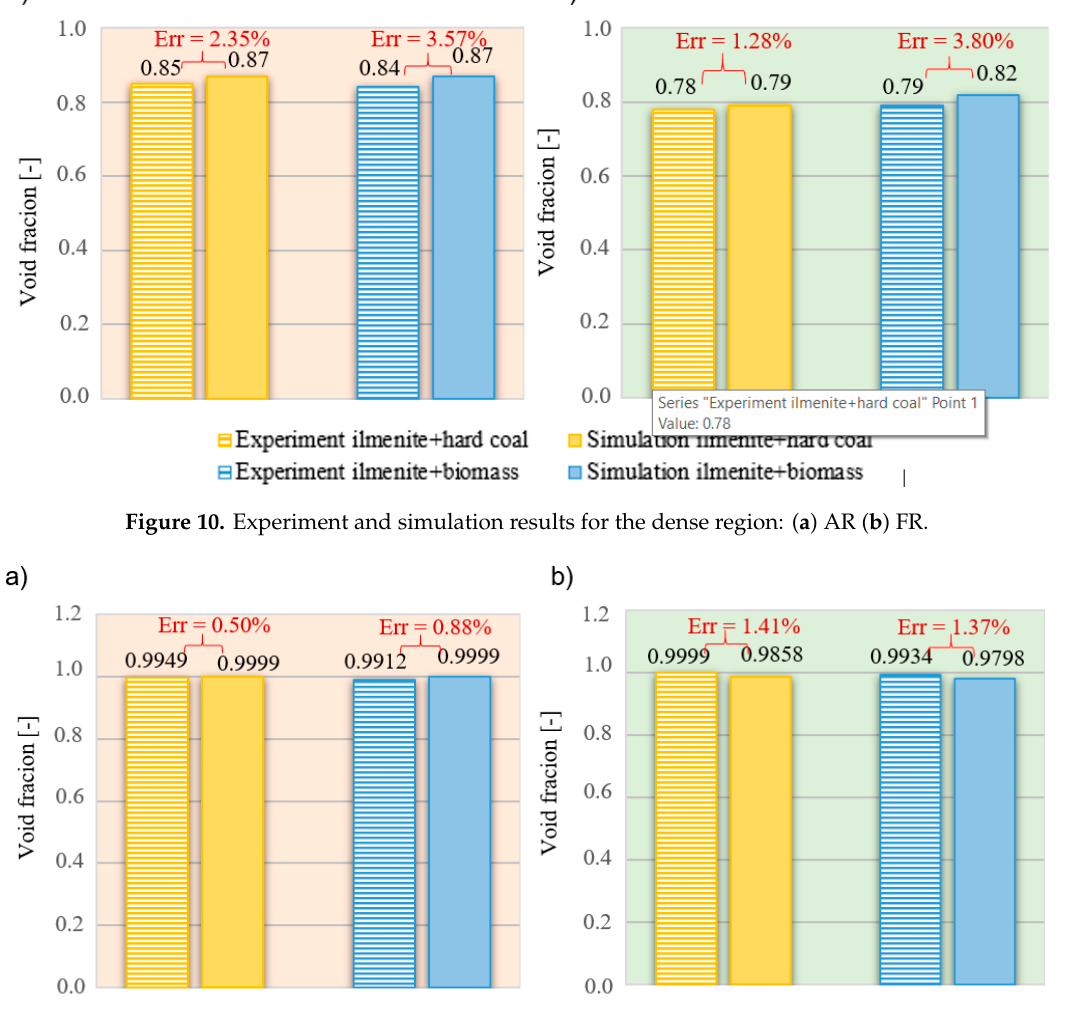
Figure 12. Experiment and simulation results for gas mass flow rate: ( a ) AR ( b ) FR. The above comparison showed that the maximum relative error for the gas mass flow rate is 3.8% in the FR and 1.02% in the AR. 3.1.5. Superficial Gas Velocity in the Bed The comparison between measured and calculated results for superficial gas velocity in the AR and FR is shown in Figure 13.